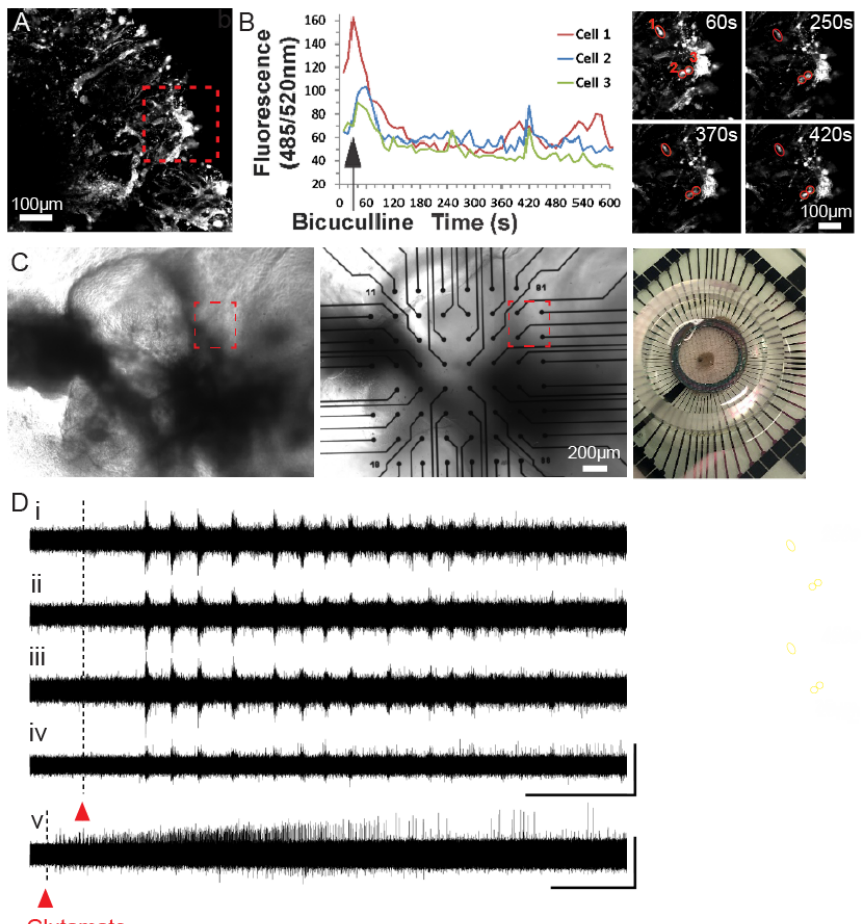
Figure 5. Neuronal network function of brain organoids. ( A ): Cells labelled with fluorescent calcium indicator, Fluo-4. Inset indicates the region of cells evaluated for calcium flux. ( B ): Time course of bicuculline-induced calcium flux for individual neurons 1–3 that are denoted in the corresponding photomicrographs. ( C ): Bright-field photomicrographs of a 55-day old (4 days iPSC expansion + 7 days neural induction + 44 days neural differentiation) organoid on an MEA showing both the region of extracellular electrophysiological recording and the configuration of electrodes. ( D ): Electro- physiological recordings from 4 electrodes (i–iv) across a single organoid surface, with synchronous bursting across the organoid surface in response to glutamate addition. The lower trace (v) repeats trace (iv) over a longer time course and shows the single cell spiking activity increasing in amplitude following initial glutamate response. Timing of glutamate addition is indicated by dashed line. Scale bars (i–iv) 50 µ V vertical, 20 s horizontal, and (v) 50 µ V vertical, 100 s